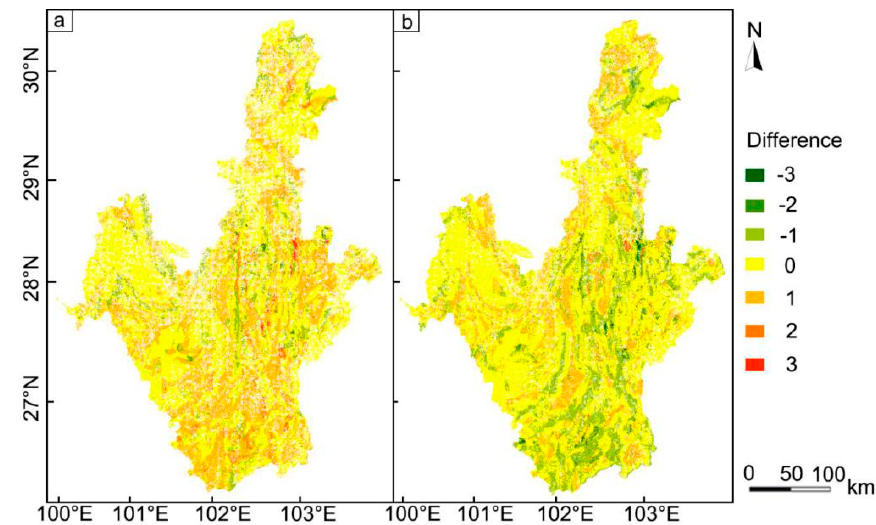
Figure 9. Maps of the di ff erences between the assessment levels: ( a ) di ff erence between 1992 and 2000; ( b ) di ff erence between 2000 and 2009. Table 6. Differences in the assessment levels.